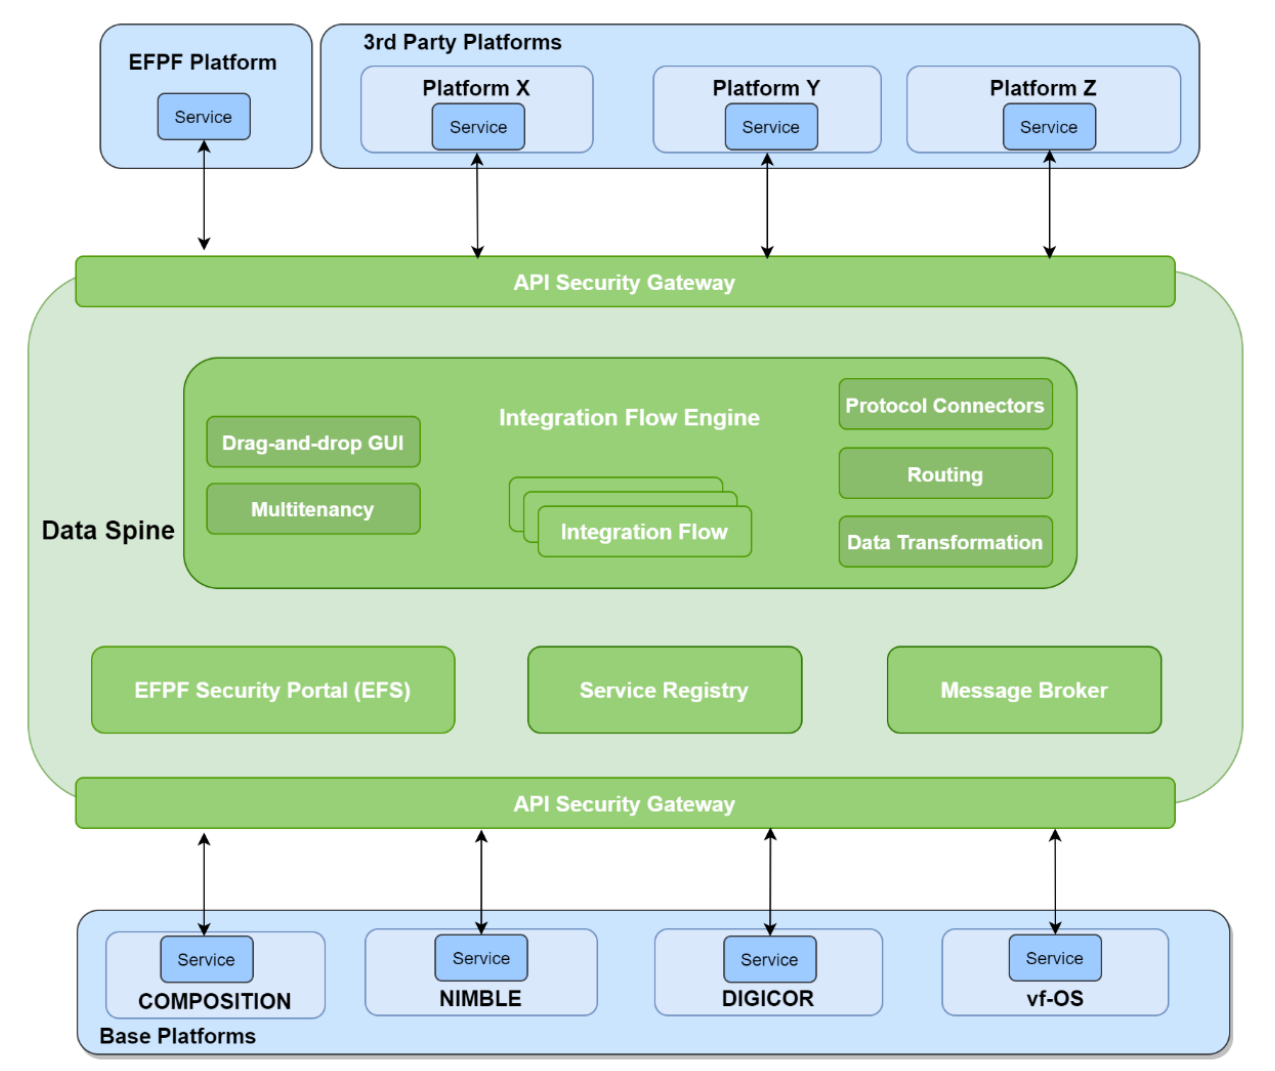
Figure 3. High-level architecture of the Data Spine.